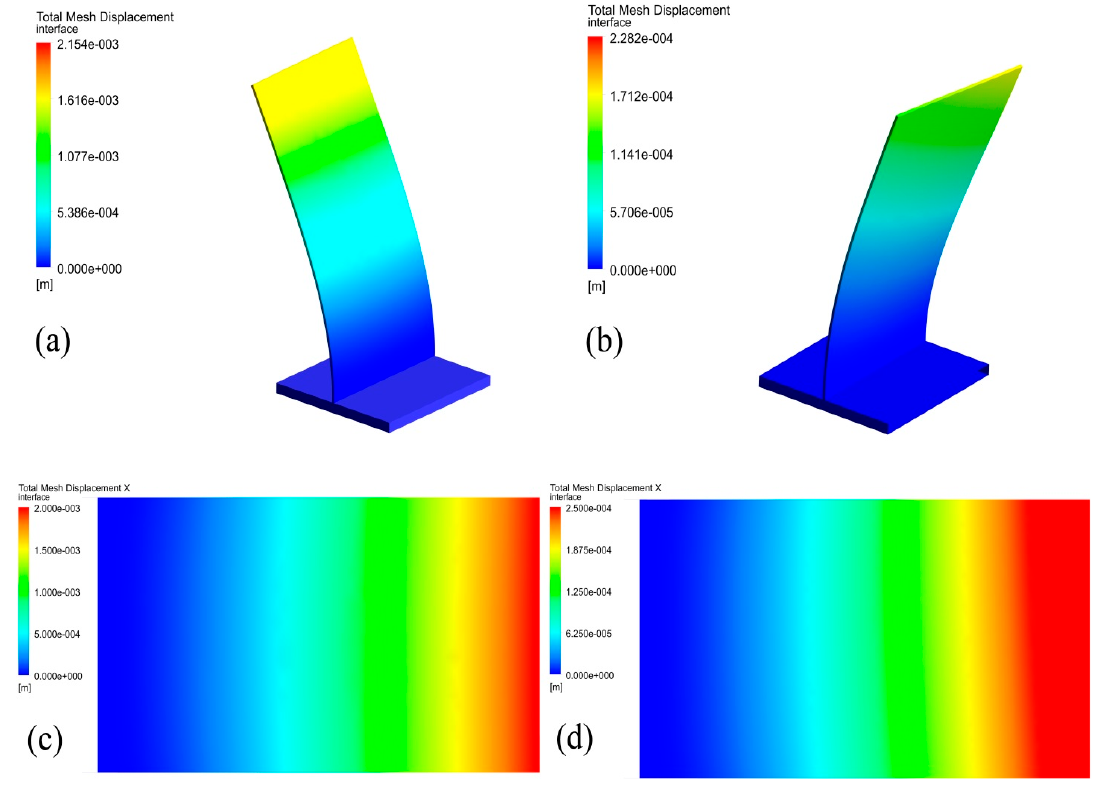
Figure 19. Deflection contour of model ( a ) 19 m/s isometric ( b ) 25 m/s isometric ( c ) 19 m/s top ( d ) 25 m/s top.